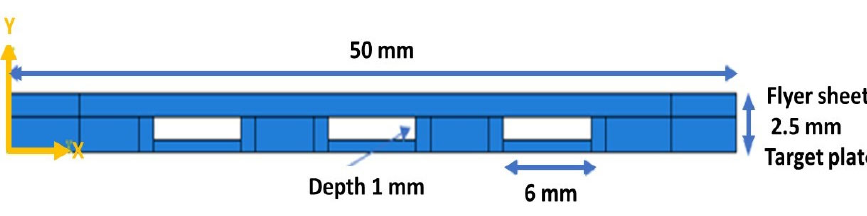
Table 1. Johnson–Cook model parameters for AA5052 for plasticity.